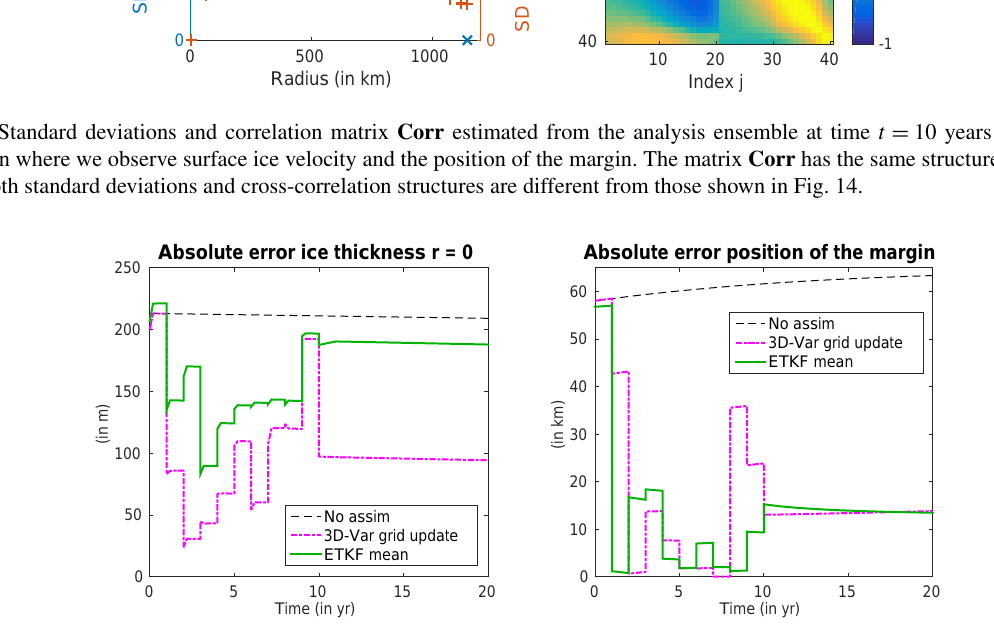
Figure 18. Evolution of the absolute error of the estimated ice thickness at r = 0 and the estimated position of the margin when we observe surface ice velocities and the position of the margin in the advanced configuration. We compare the absolute errors obtained when we use 3D-Var with the correction of the grid-node positions and when we use an ETKF. The ETKF performs better than the 3D-Var with respect to the position of the margin, but 3D-Var gives better results for the ice thickness at r = 0 in this